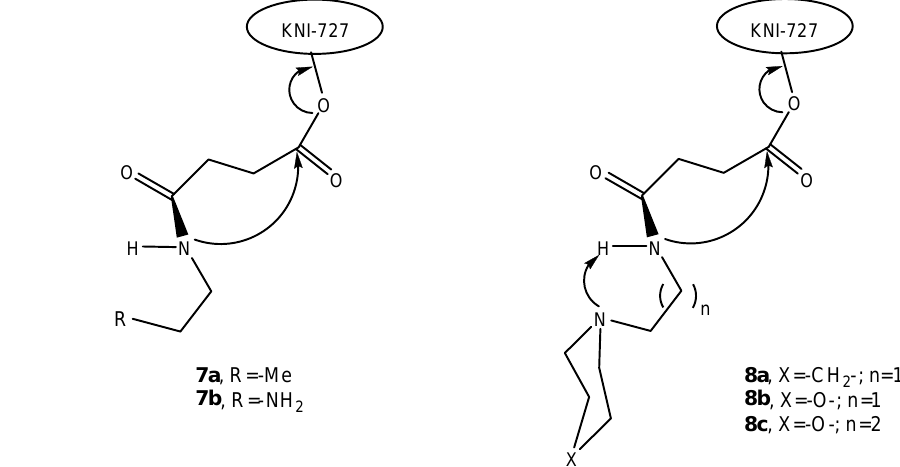
Figure 1. Intramolecular activation of water-soluble prodrugs of KNI-727